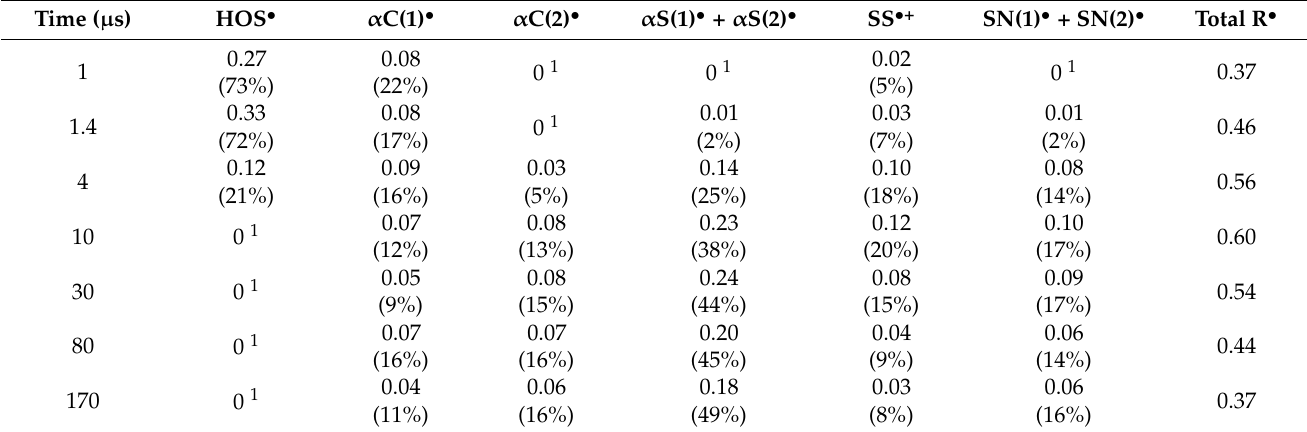
Table 1. The radiation chemical yields ( G , µ mol J − 1 ) of radicals and their percentage contribution (in parenthesis) to the total yield of radicals present in the reaction of HO • with Met-containing derivative 1 at different times after the electron pulse at pH 7.